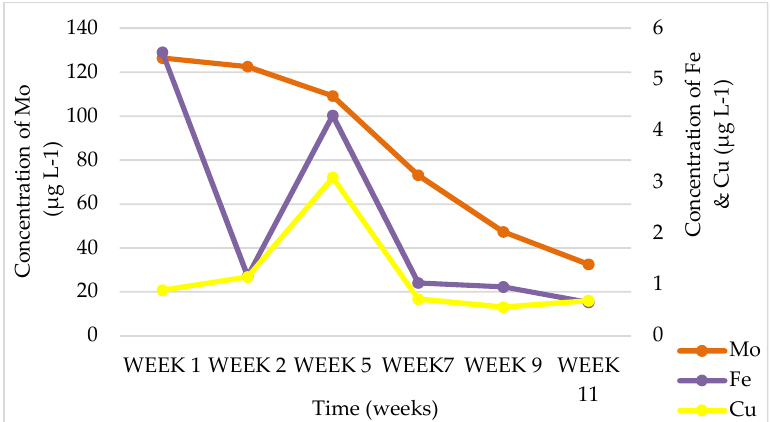
Figure 9. Chemical-element concentrations in leachates obtained from CFA (Coal-fly-ash) pots growing S. Oleracea L. for essential elements Fe, Mo, and Cu.